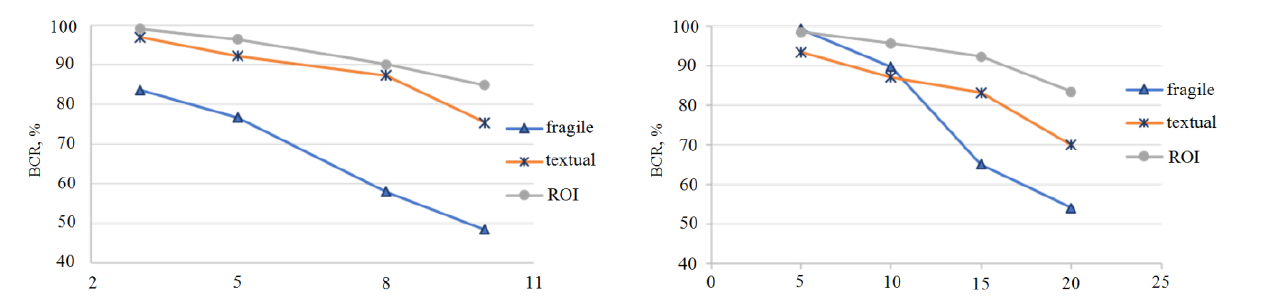
Figure 7. Watermark distortions under translation attacks